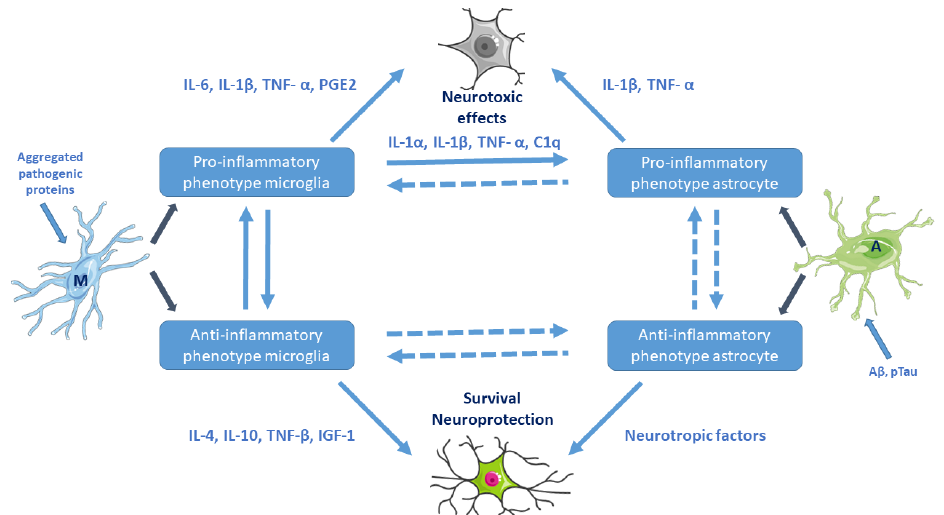
Figure 2. Activation of microglia and astrocytes (e.g., by aggregated pathogenic proteins) and their cross-talk. Pro-inflammatory microglial cells are neurotoxic. Reactive astrocytes can be both beneficial and harmful to surrounding neurons. Microglia–astrocyte cross-talk is maintained by secreted canonical cytokines, growth factors, neurotransmitters, glia-transmitters, and chemokines. M: resting microglia, A: naive astrocyte. (Based on Kwon et al. 2020, Ref. [36]. Cell images from the Servier Medical Art repository were used.)